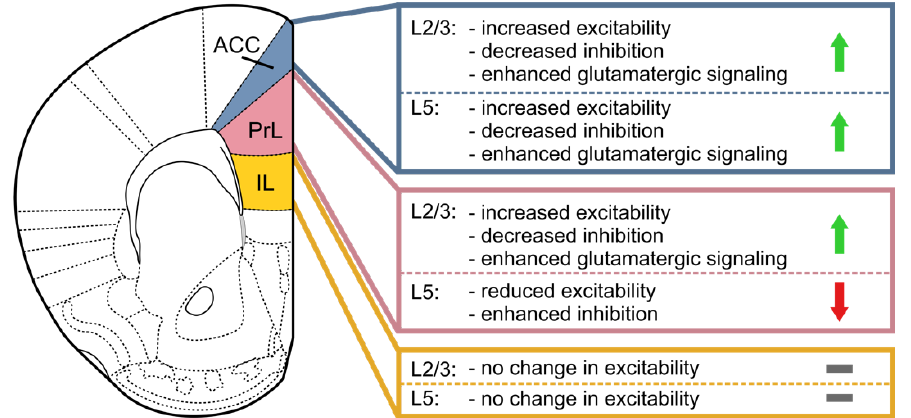
Figure 2. Schematic of pain-induced changes of L2/3 and L5 excitability in the mPFC subregions. Green arrows indicate a net increase in excitability, red arrow indicates a net decrease in excitability, gray minuses indicate no reported excitability changes.